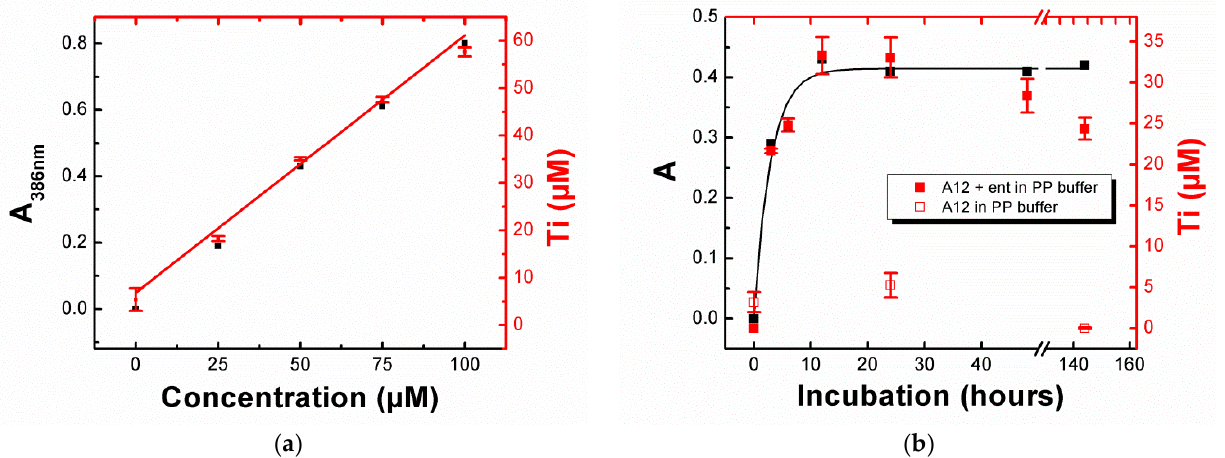
The average diameter and polydispersity of the suspensions were determined by DLS measurements. Quantifica- for bacteria to take up solubilized Ti in these conditions will be further investigated in tion of Ti solubilized from NPs (5 mg/mL) by enterobactin ( ent ) (50 µ M) determined by ICP-AES. (1) [Ti] 0 : amount Section 3.7. of Ti released by the TiO 2 -NPs without ent (labile Ti), (2) [Ti] ent : amount of Ti released after incubation of TiO 2 -NP with ent , b.d.: below detection limit, (*) in number. (3) Laisney et al. [33]. (4) Teulon et al. [43].